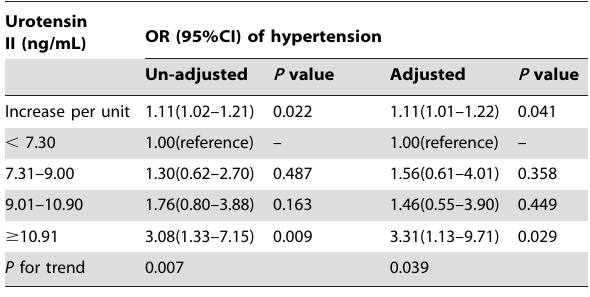
Table 3. Odds ratio and 95% confidence interval of hypertension associated with different plasma urotensin II levels in nitric oxide level-matched pairs of subjects (106 pairs) 1